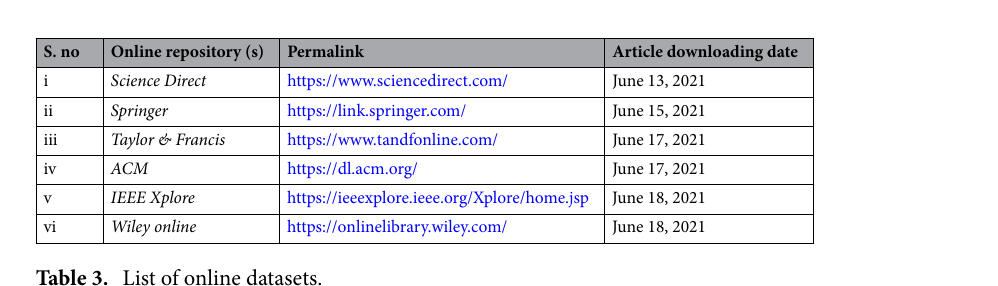
Table 2. Generalized query.